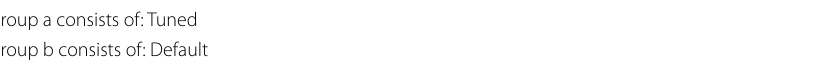
Table 11 HSD test groupings after ANOVA of AUC for the hyperparameters